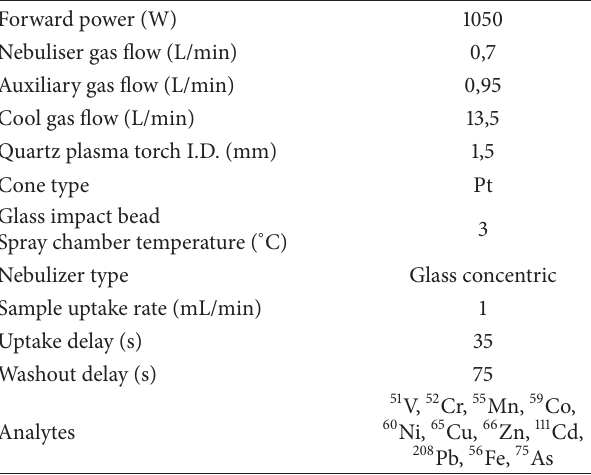
Table 1: Operating conditions